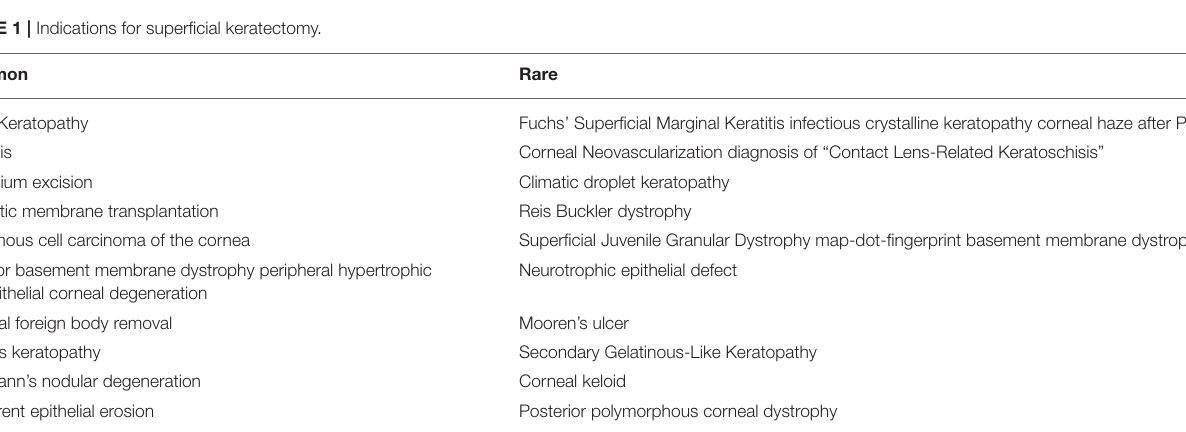
TABLE 1 | Indications for superficial